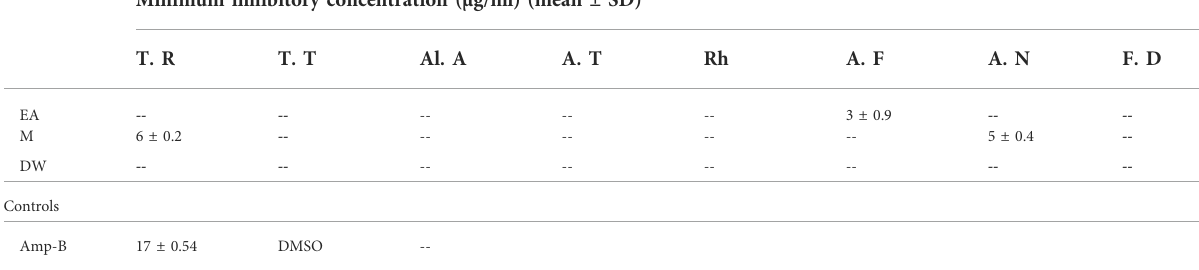
Values(mean±SD)areaverageoftriplicateanalysisofeachplantextract(nvalueof1×3).Thesampleconcentrationwas500,250,125,62.5,and31.25 μ g/mlineachcorrespondingwellof the 96-well plate. EA, ethyl acetate extract, M, methanolic extract; DW, distilled water extract; --, No activity; T.R, Trichophyton rubrum ; T. T, Trihcophyton tonsurans ; Al. A, Alternaria alternata ;Rh, Rhizopusarrhizus ;A.F, Aspergillus fl avus; A.N, Aspergillusniger ;F.D, Fusariumdimerum ;Terb,terbina fi ne;Amp-B,amphotericinB;**,discdiffusionmethodwasapplied for screening against Candida albicans